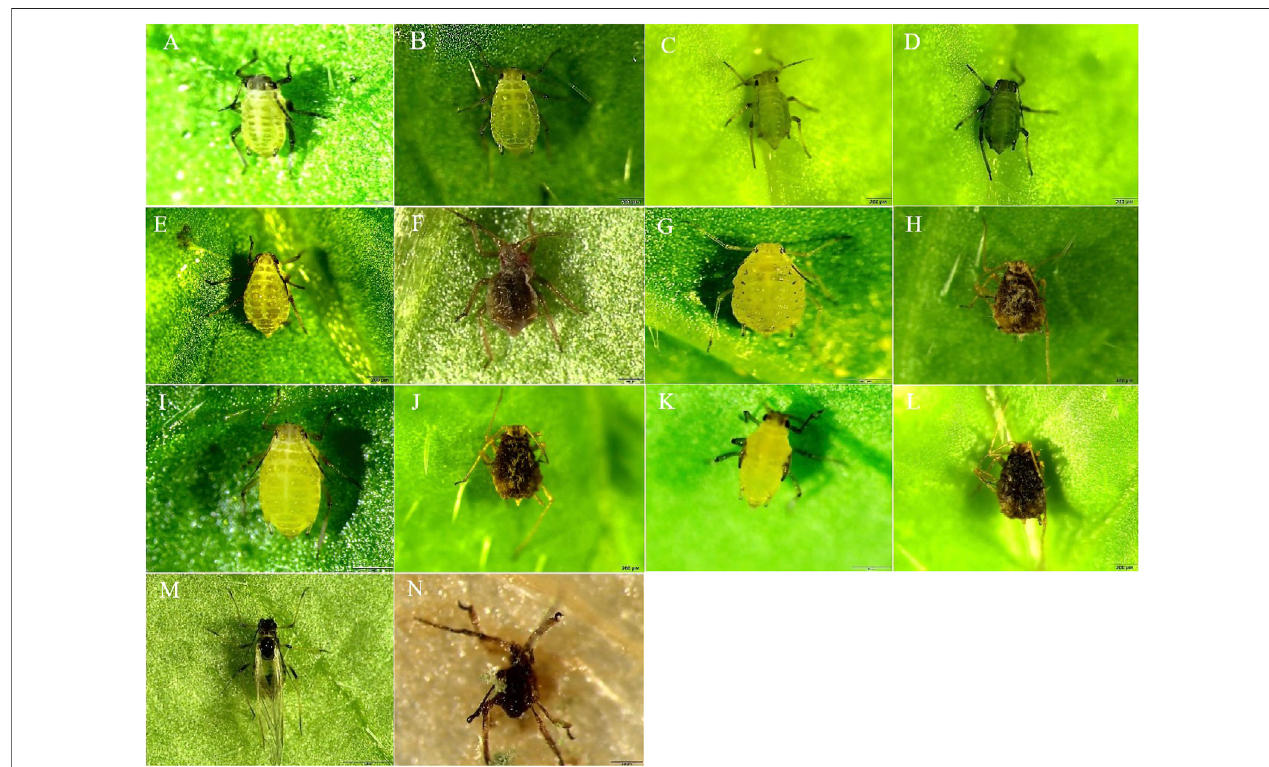
FIGURE2| Theparasiticeffectof T.longibrachiatum T6sporesuspensionon B.brassicae fromDay1today7post-inoculation. (A,B) showsDay1controlandT6- treated B.brassicae ; (C,D) showsDay2controlandT6-treated B.brassicae ; (E,F) showsDay3controlandT6-treated B.brassicae ; (G,H) showsDay4controlandT6- treated B.brassicae ; (I,J) showsDay5controlandT6-treated B.brassicae ; (K,L) showsDay6controlandT6-treated B.brassicae ; (M,N) showsDay7controlandT6- treated B. brassicae .